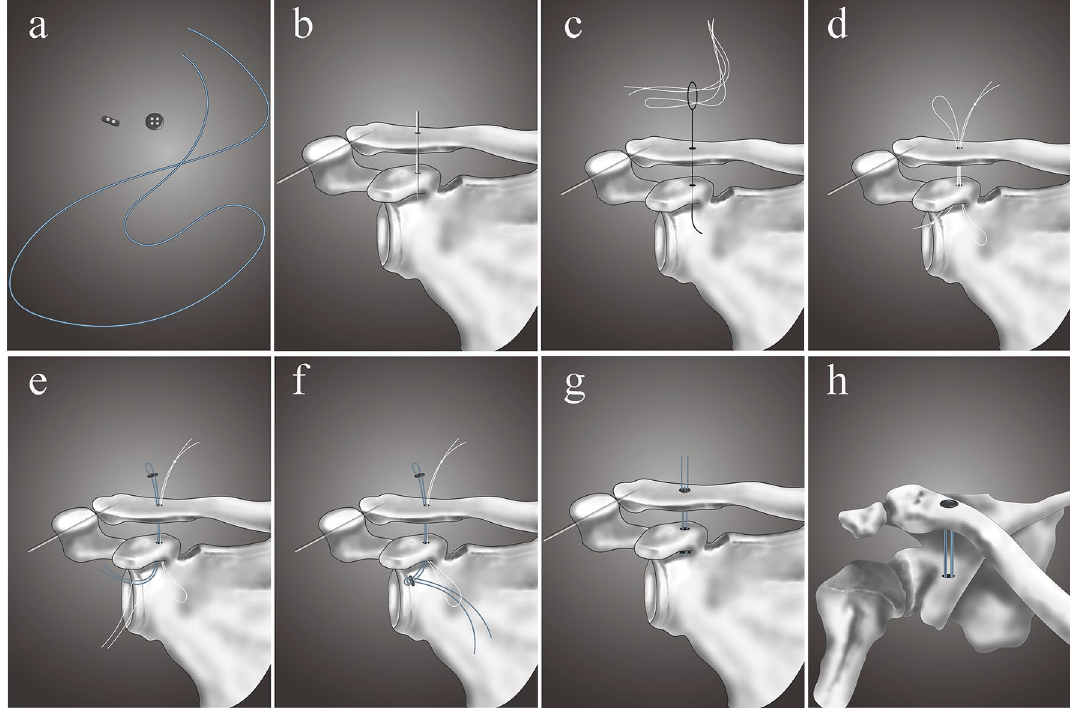
Figure 4. MITR modified operative procedures. ( a ) The TR system is dismantled. ( b ) A 2.5-mm Kirschner wire is introduced through the clavicle and coracoid. ( c,d ) The two white traction sutures are passed through the tunnels using a nitinol suture passing wire. ( e,f ) The TR system is introduced through the tunnels using the two white traction sutures and then reassembled. ( h ) Final frontal view of AC joint fixation with the TR